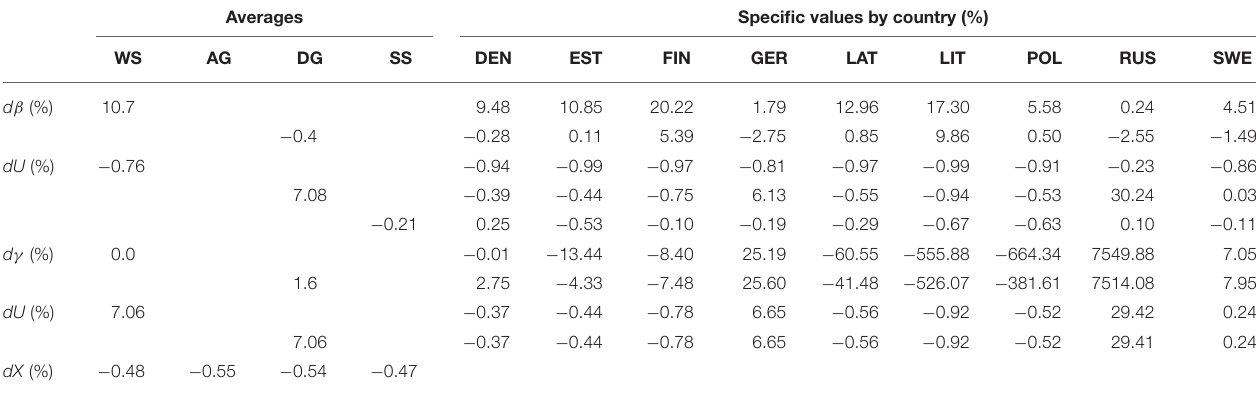
TABLE 6 | Baltic Sea: non-cooperative solutions. Averages Specific values by country (%)